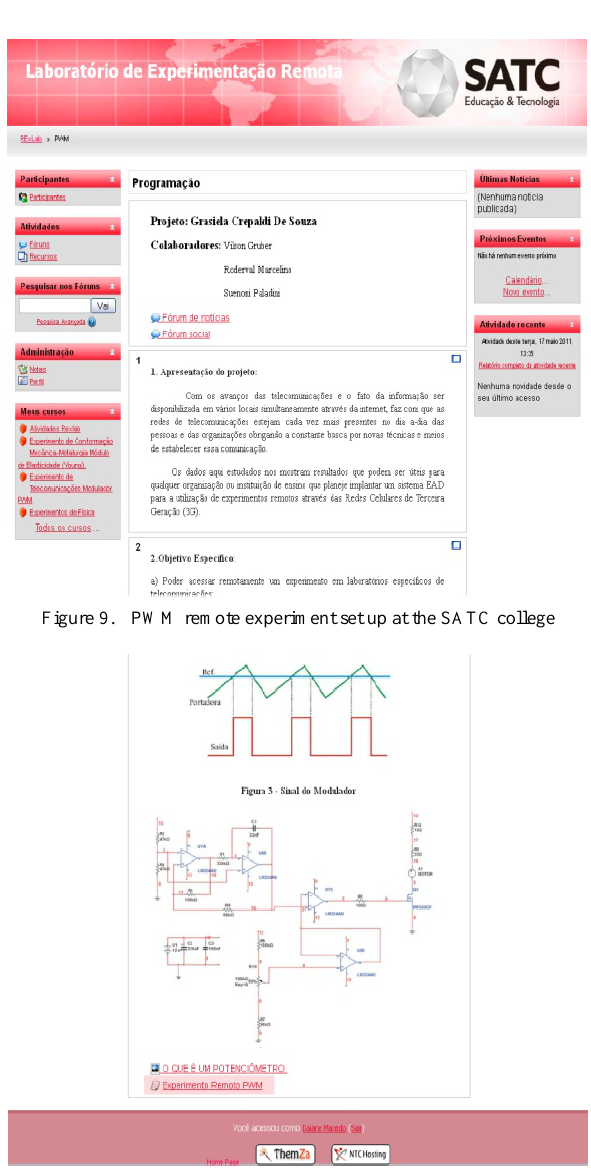
Figure 10. Moodle platform structure with the theoretical base of the experiment